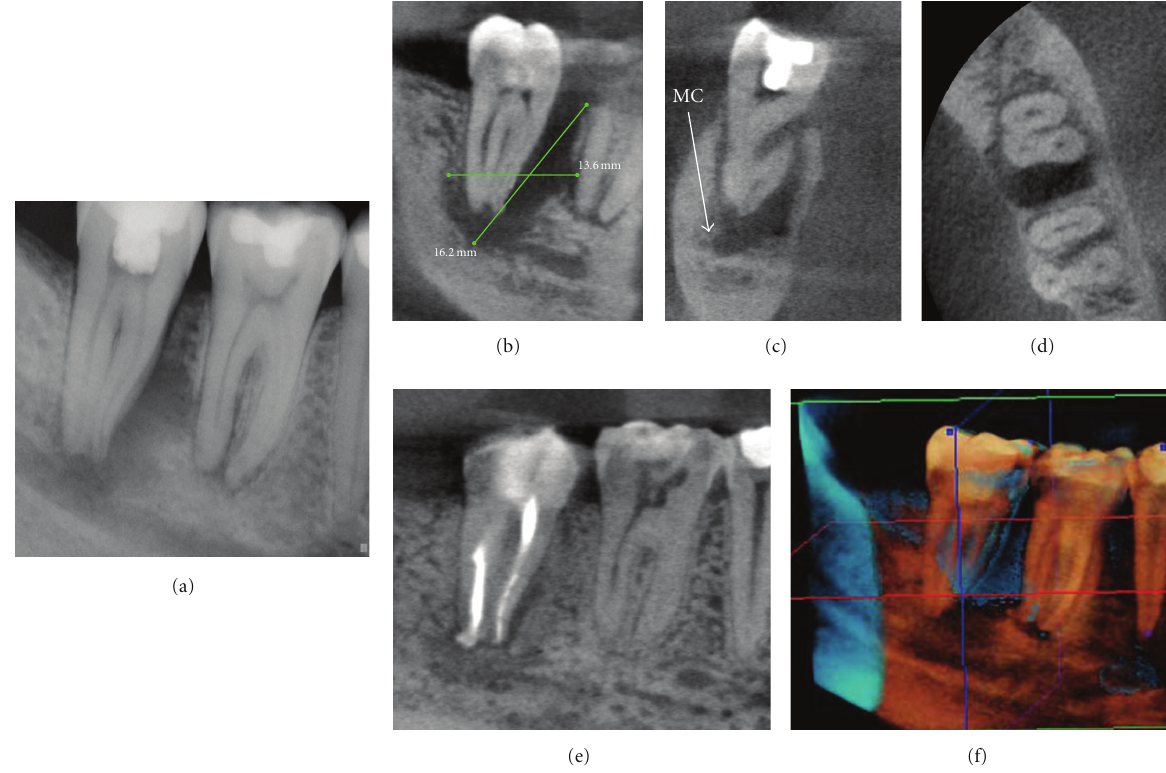
Figure 5: Treatment of large destructive lesions associated with pulpal pathosis benefit from 3D imaging providing better visualization of the spatial relationships of the tooth to anatomic landmarks and canal morphology. This patient presented with mild dysthesia of the right mandibular dentition. Conventional periapical imaging (a) demonstrated a large apical and mesial ill-defined rarefaction associated with the right mandibular second molar in close proximity to the inferior alveolar nerve. CBCT images ((b) sagittal, (c) cross-sectional, (d) axial) demonstrate the proximity of the lesion to the mandibular canal (MC). Therefore during treatment great care was taken to prevent obturation material extrusion past the apical terminus and possible traumatization of the IAN. Additional parasagittal CBCT images document the progression of healing at 6 months (e). In addition digital subtraction composite 3D imaging at 6 months (f) provides three-dimensional visualization of healing. (Data acquired at 0.076 mm resolution on an KODAK Dental Imaging 9000 DS (Dental Imaging/Practiceworks Atlanta, GA, USA) and 3D subtraction composite reformatted using InVivo Dental (Anatomage, San Jose,